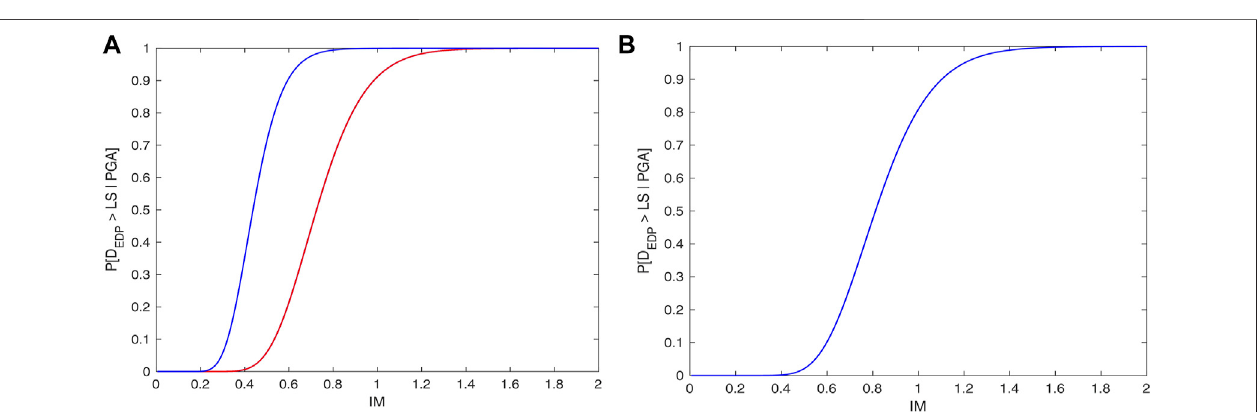
FIGURE 10 | (A) Fragility curves of a stabilization oil column: excessive rotation of the columns ’ base (blue line: yielding; red line: collapse). (B) Fragility curves of a stabilization oil column: excessive rotation at the fl ange joint of the outlet acid gas pipe.